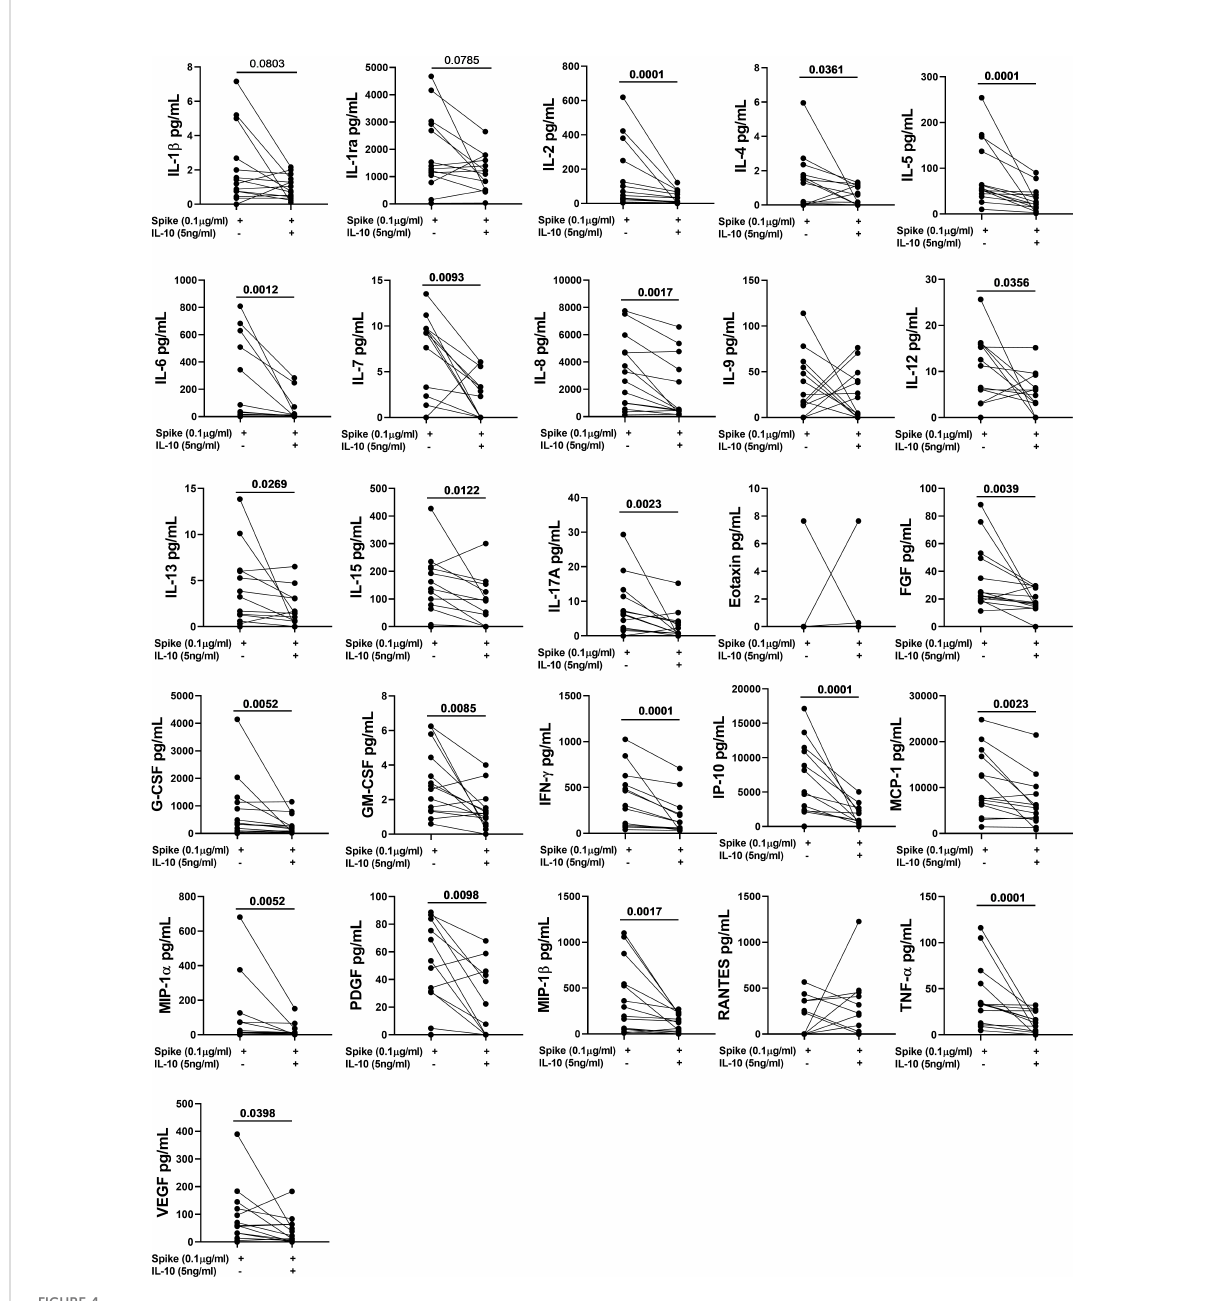
FIGURE 4 IL-10 signi fi cantly downregulates several Spike-induced cytokines, chemokines, and growth factors in COVID-19 Patients of study population “ B ” . Whole-blood was stimulated or not with a pool of Spike peptides (Pool S) of SARS-COV-2 and then treated or not with IL-10. After overnight stimulation, plasma was collected and used to detect immune factors by a 27-plex multiplex assay